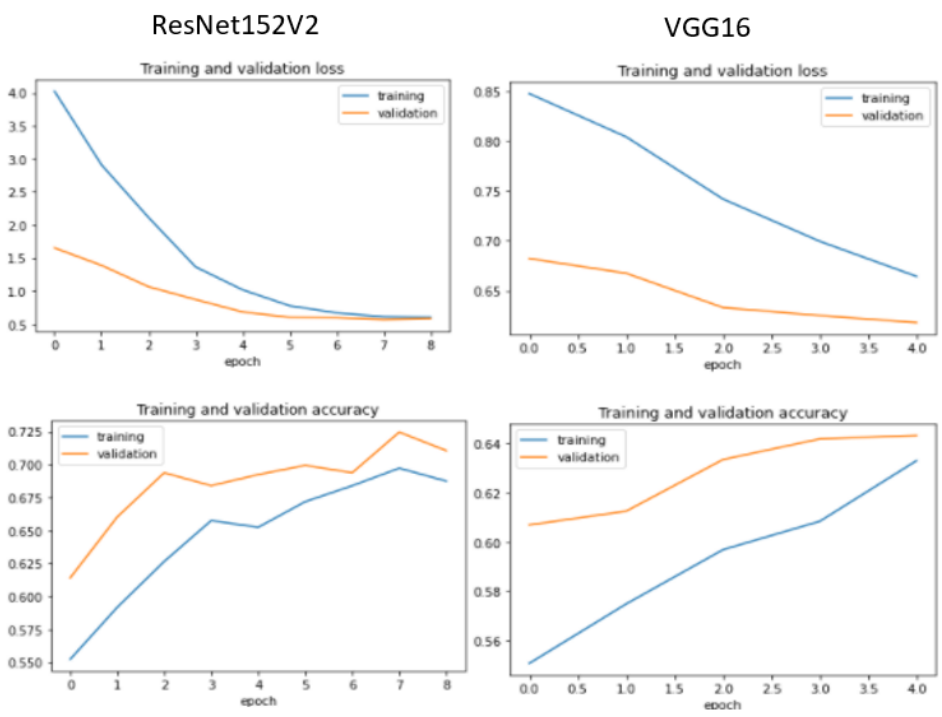
Figure 8. Training and validation performance for ResNet152V2 and VGG16.